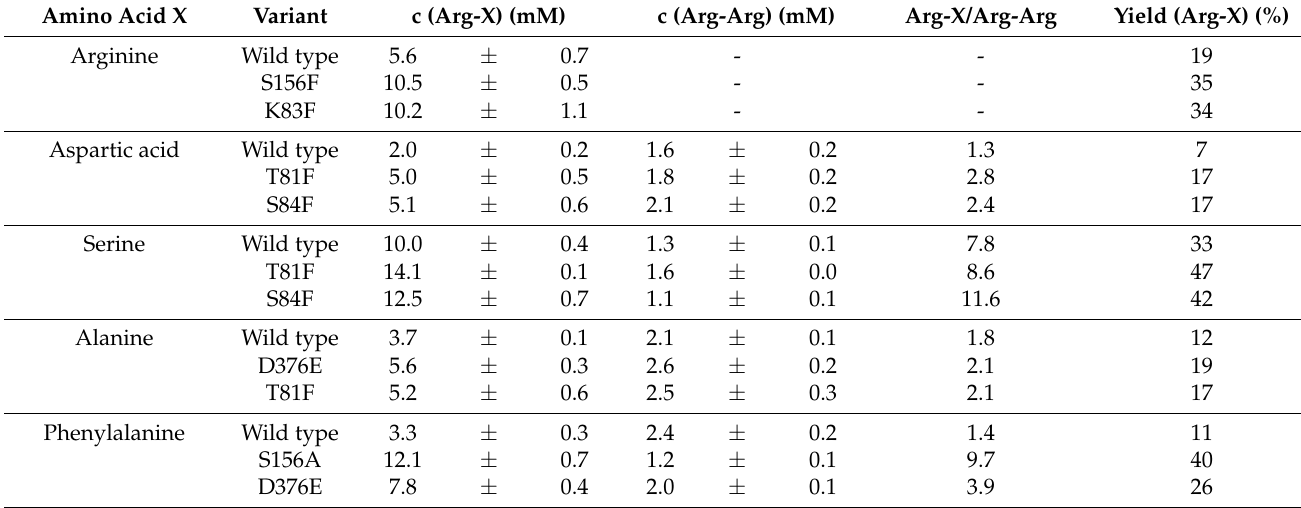
Table 1. Variants with the highest biocatalytic performance for the production of Arg-X dipeptides. Amino Acid X Variant